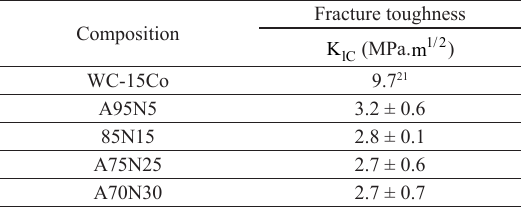
Table 3. Indentation toughness of